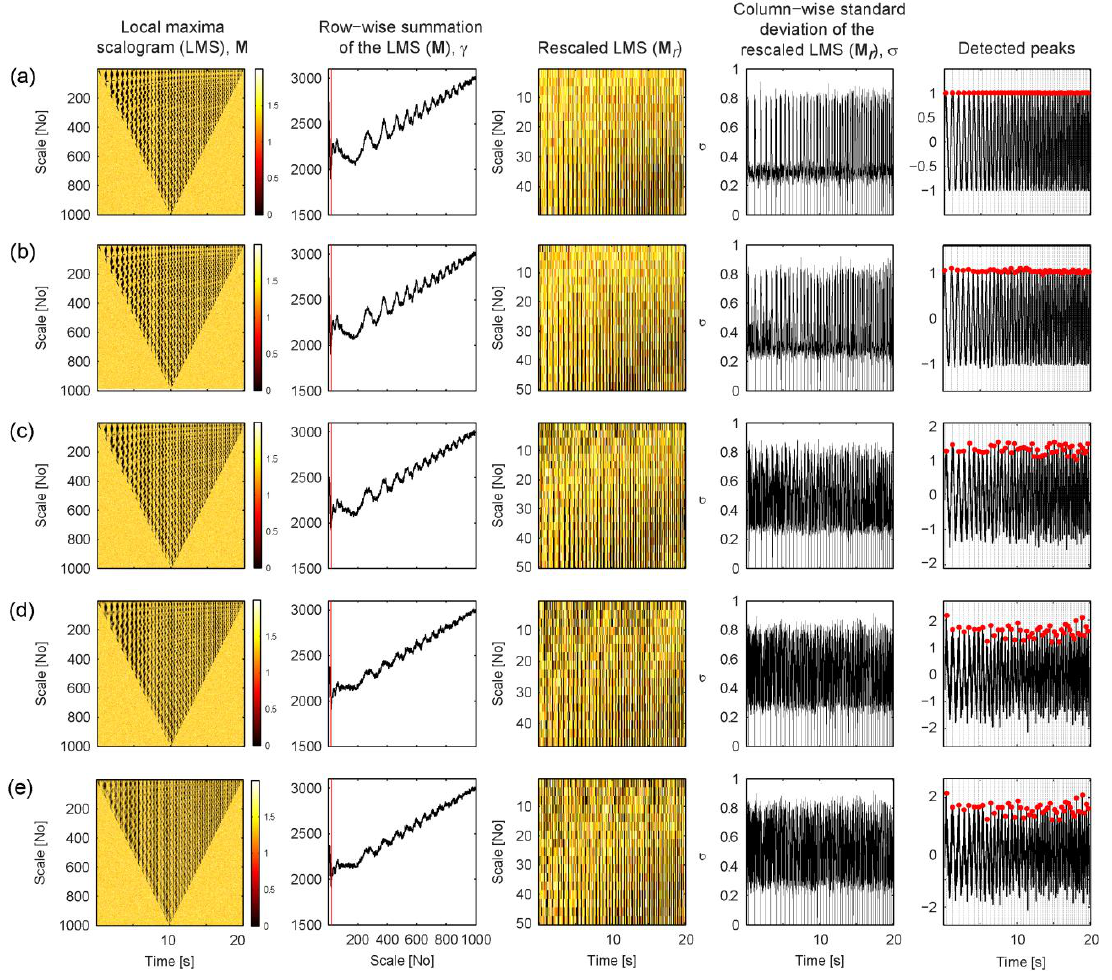
Figure 4. Results of applying the AMPD algorithm to the simulated type B data